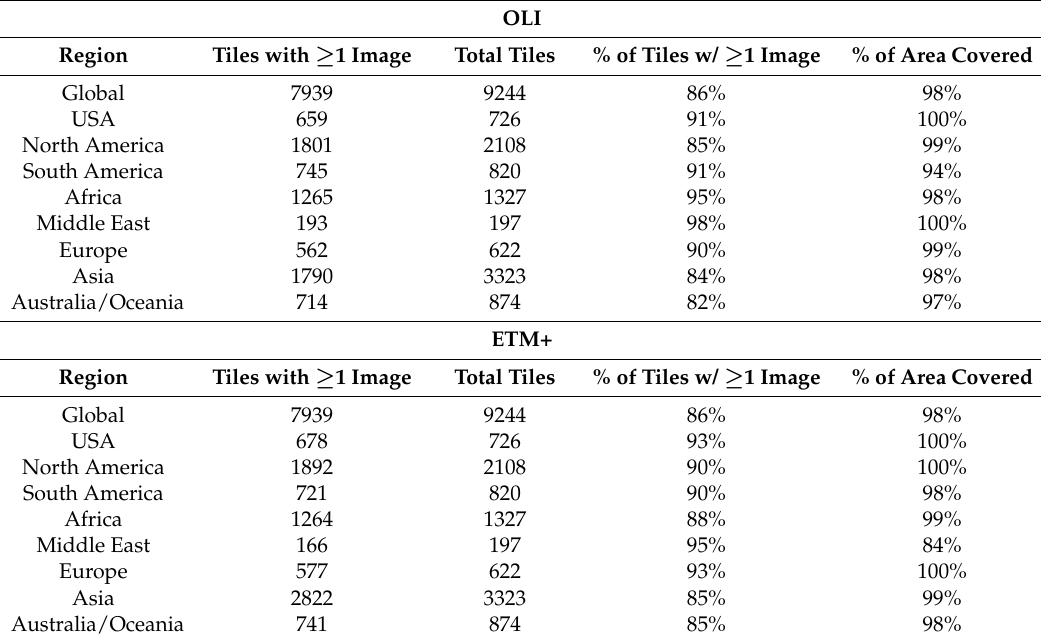
Table 1. Coverage of Seasonally Appropriate Landsat